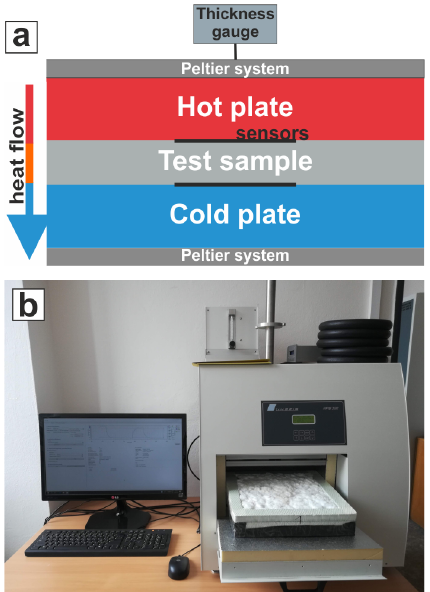
Figure 1. a) Schematic drawing and b) photograph of the Linseis heat flow meter instrument used for the measurement of the thermal conductivity